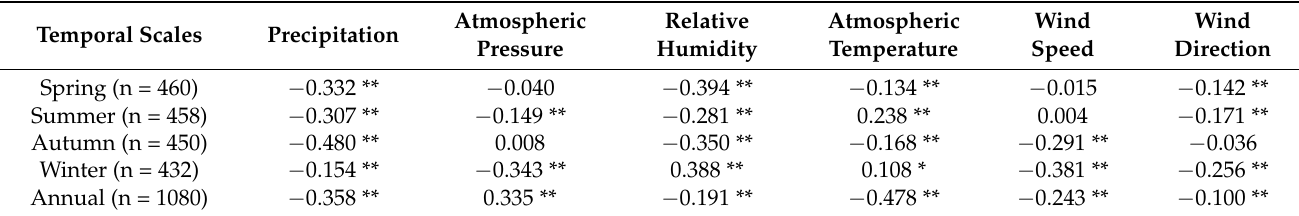
Table 3. Spearman correlations and multivariate progressive linear regression between PM10 and meteorological factors in Xi’an.